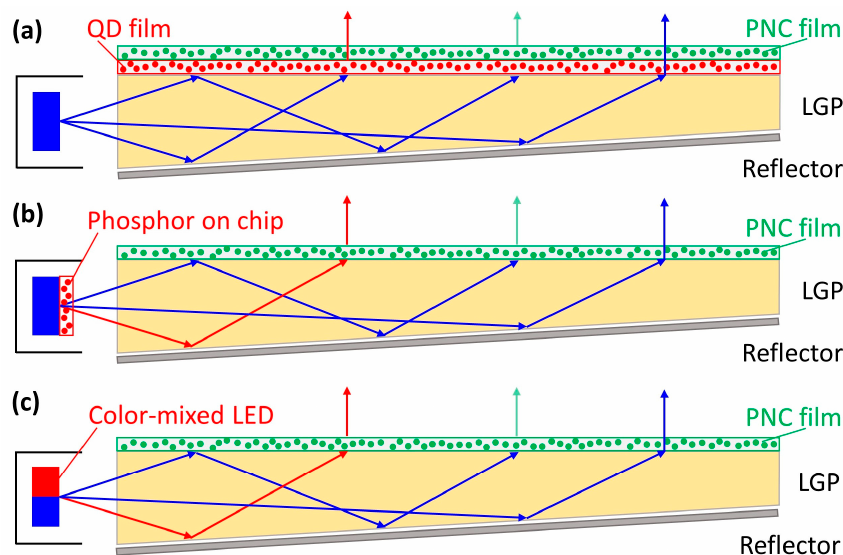
Figure 9. Schematic diagram for three different hybrid configurations implementing on-surface PNC films with ( a ) on-surface red quantum-dots (QD) film; ( b ) on-chip red phosphor; ( c ) color-mixed LED chips.